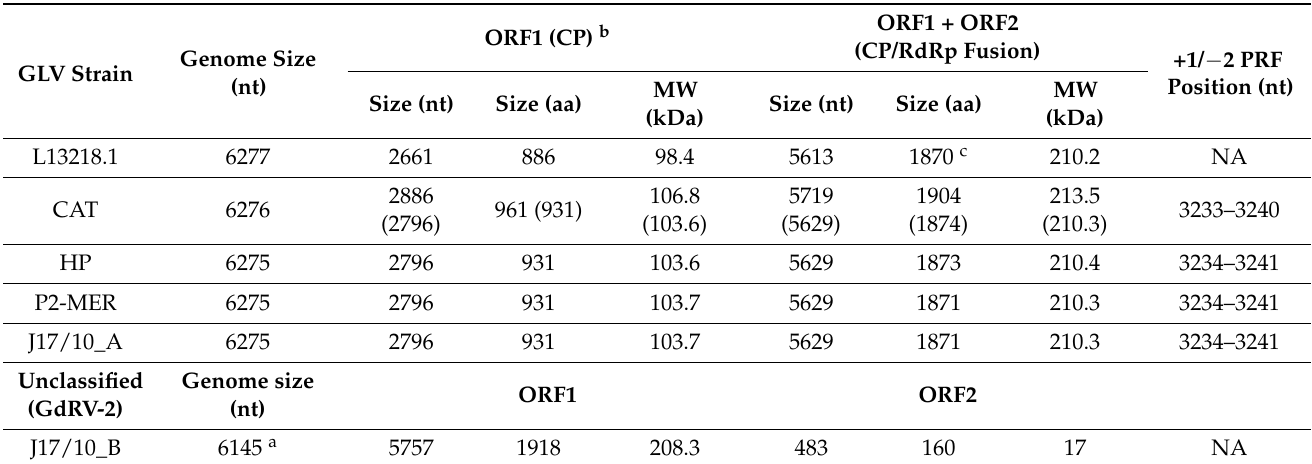
Table 2. Viral genomes